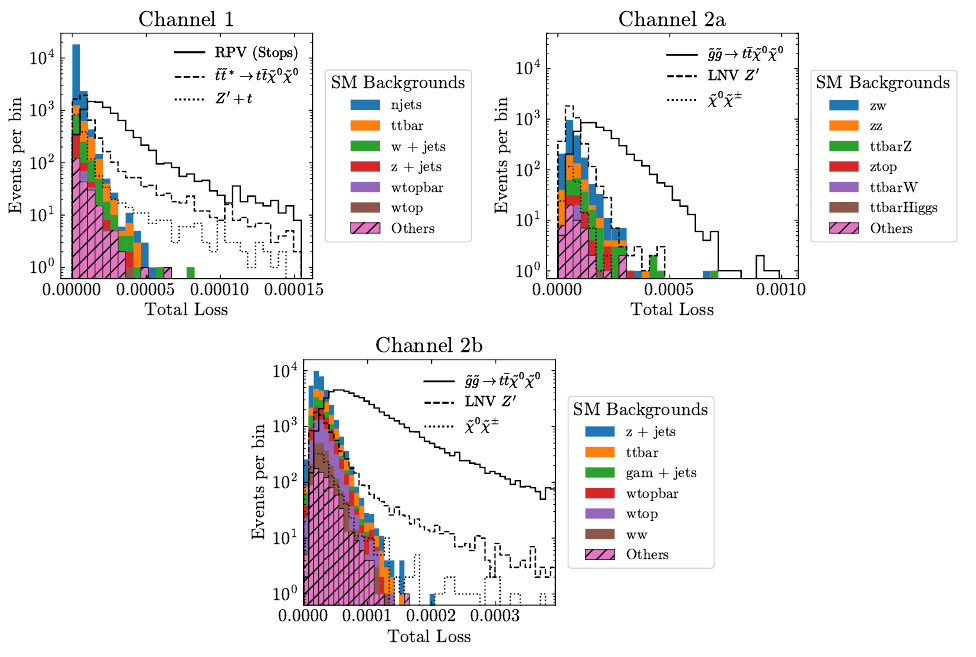
Figure 5: Anomaly score for the networks using β = 1.0 and w = 1.0. The network does not try to reconstruct the set, but only uses the KL divergence in the latent space. This leads to better signal separation than the networks which use a